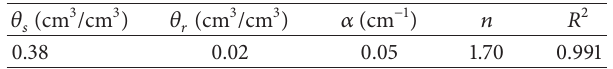
Figure 1: Water retention curve: measured data at different soil depths. Table 2: Fitting parameters of Van Genuchten’s equation for the considered sandy